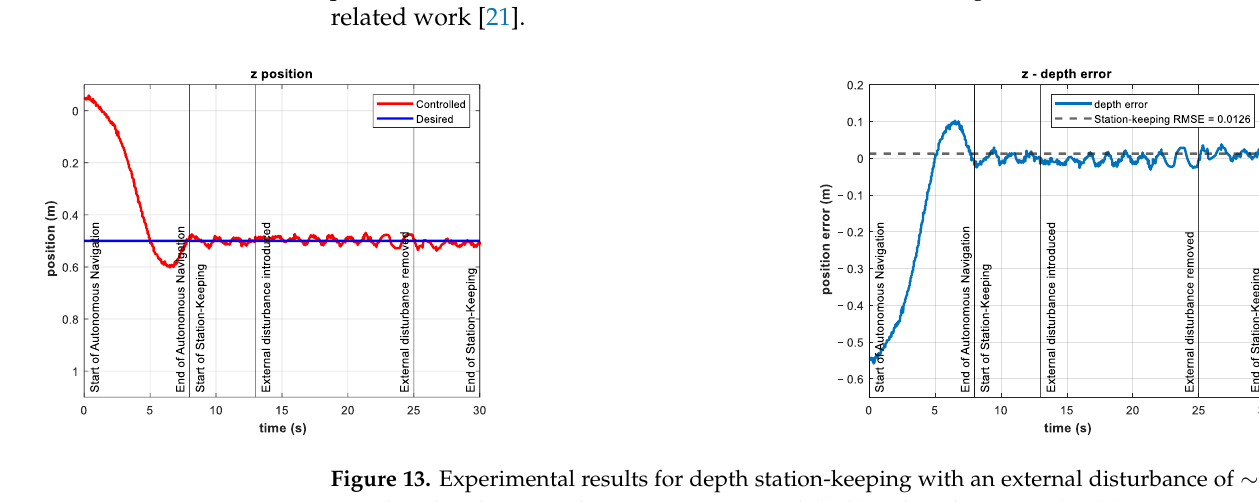
presence of unknown external disturbances of the same magnitude as in the simulations in